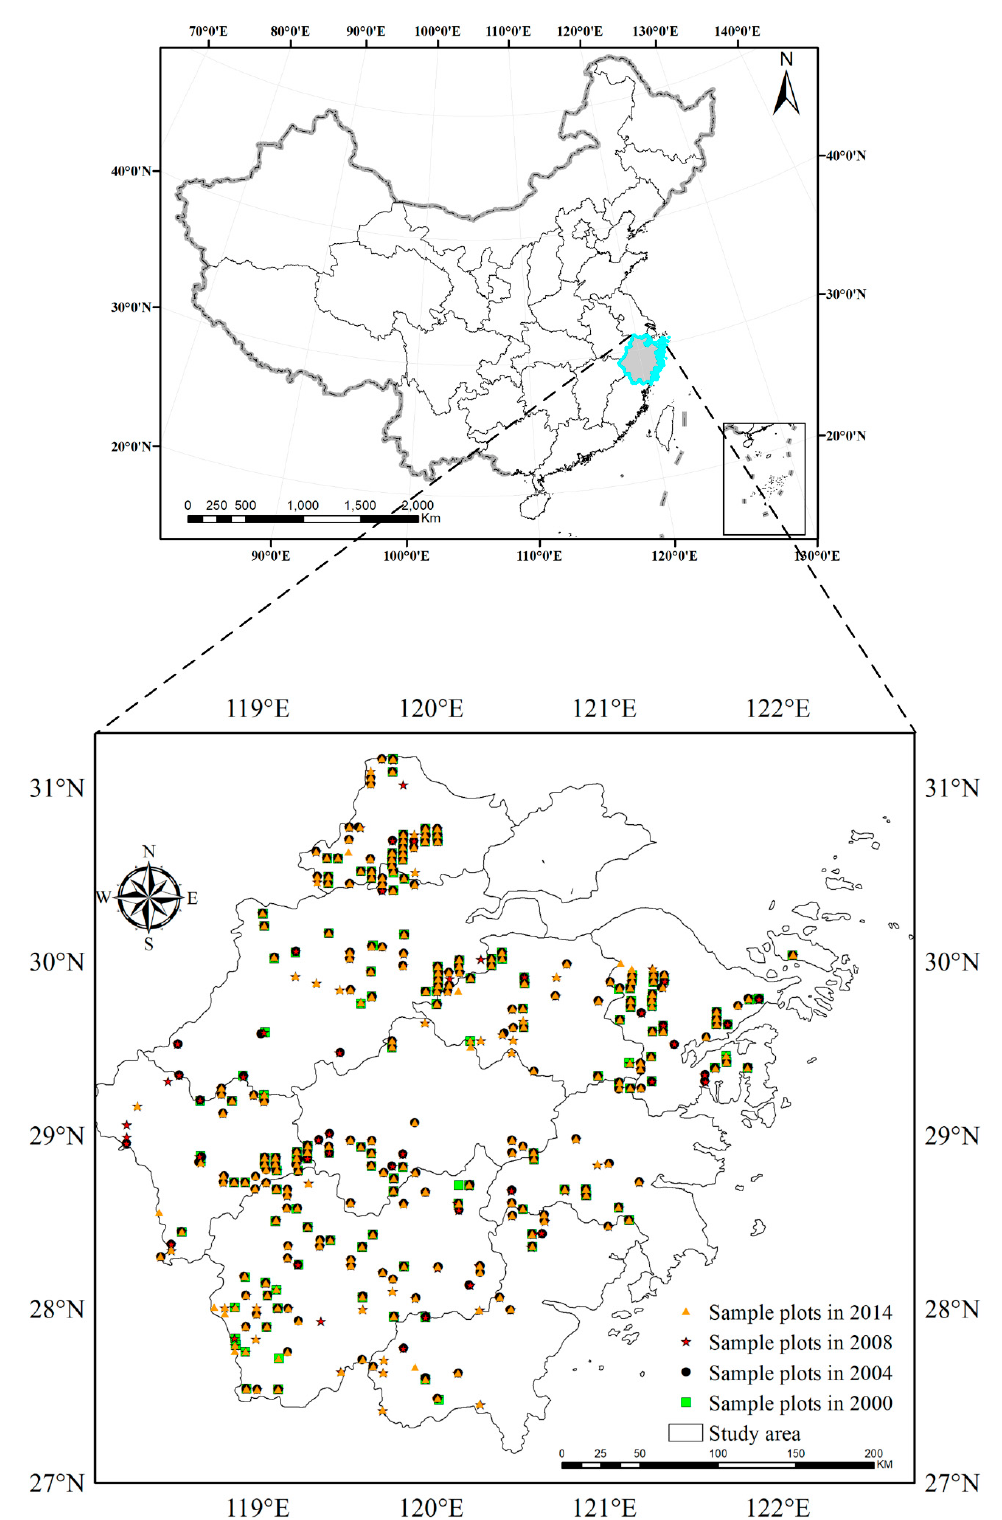
Figure 1. Study area and location of bamboo forest carbon storage sample plots.